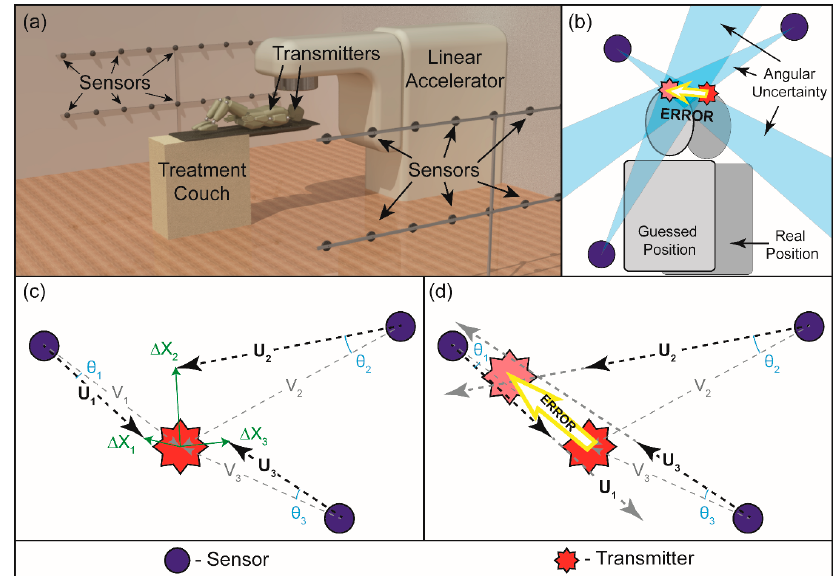
Figure 4. ( a ) Three-dimension rendering of sensor grid in the clinical setting. Transmitters are attached to the patient; ( b ) Rationale for creating the Monte Carlo simulation: angular uncertainty exists in direction measurements, which can lead to errors in the localization process; ( c ) Process of the Monte Carlo simulation: angular uncertainty θ is created by adding a vector Δ X to the true vector between sensor and transmitter V , resulting in a simulated mis-measurement of direction U . The vectors Δ X i are randomly selected from a 3D Gaussian distribution; ( d ) Continued process of the Monte Carlo simulation: a least squares calculation is used to find the best-fit intersection of the mis-measured direction vectors, U i , and the error is taken as the difference between the intersections of the mis-measured vectors U i and the intersection of the true vectors V i . The error is compared to the average angular uncertainty θ i .